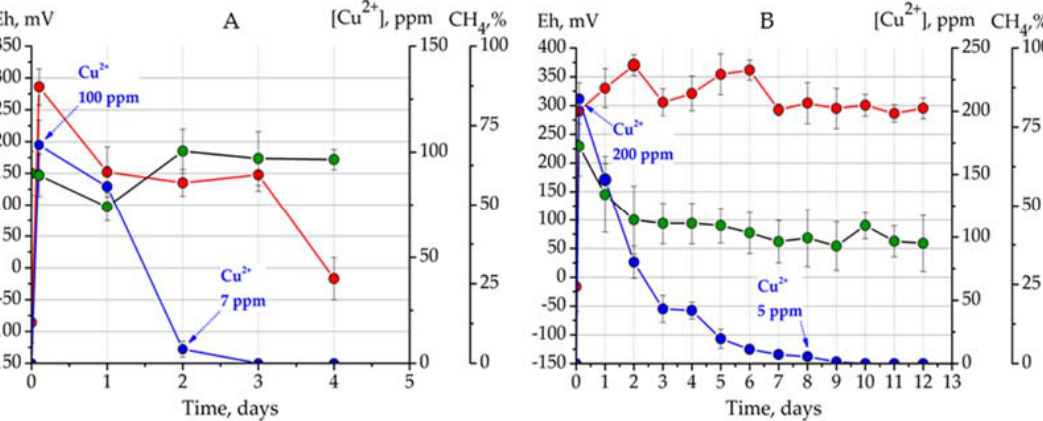
Figure 6. Effective removal of toxic copper compounds during the fermentation of pistia plants at the initial concentrations of 100 ppm ( A ) and 200 ppm ( B ) Cu 2+ .